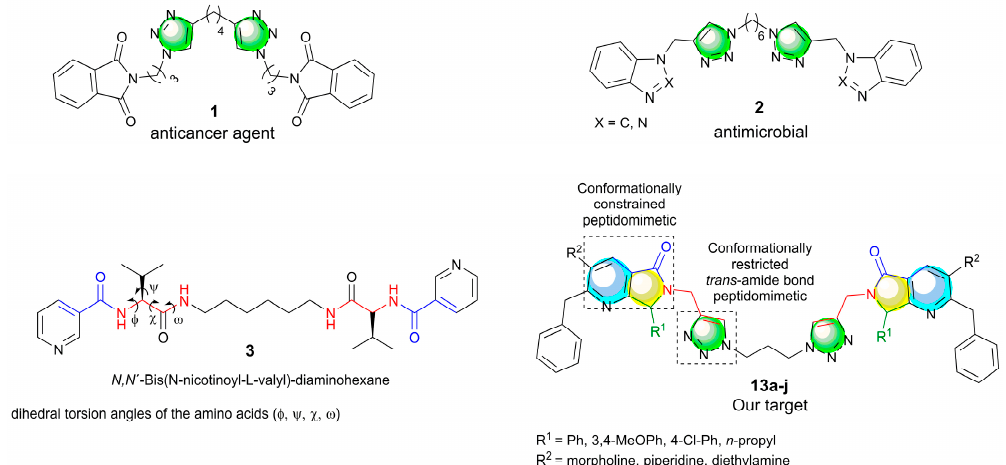
Figure 1. Bioactive, 1,2,3-triazole-linked dimers 1 and 2 , bis-( N -nicotinoyl-L-valyl, bis-derivatives of L-valine 3 and our target compound 13 .